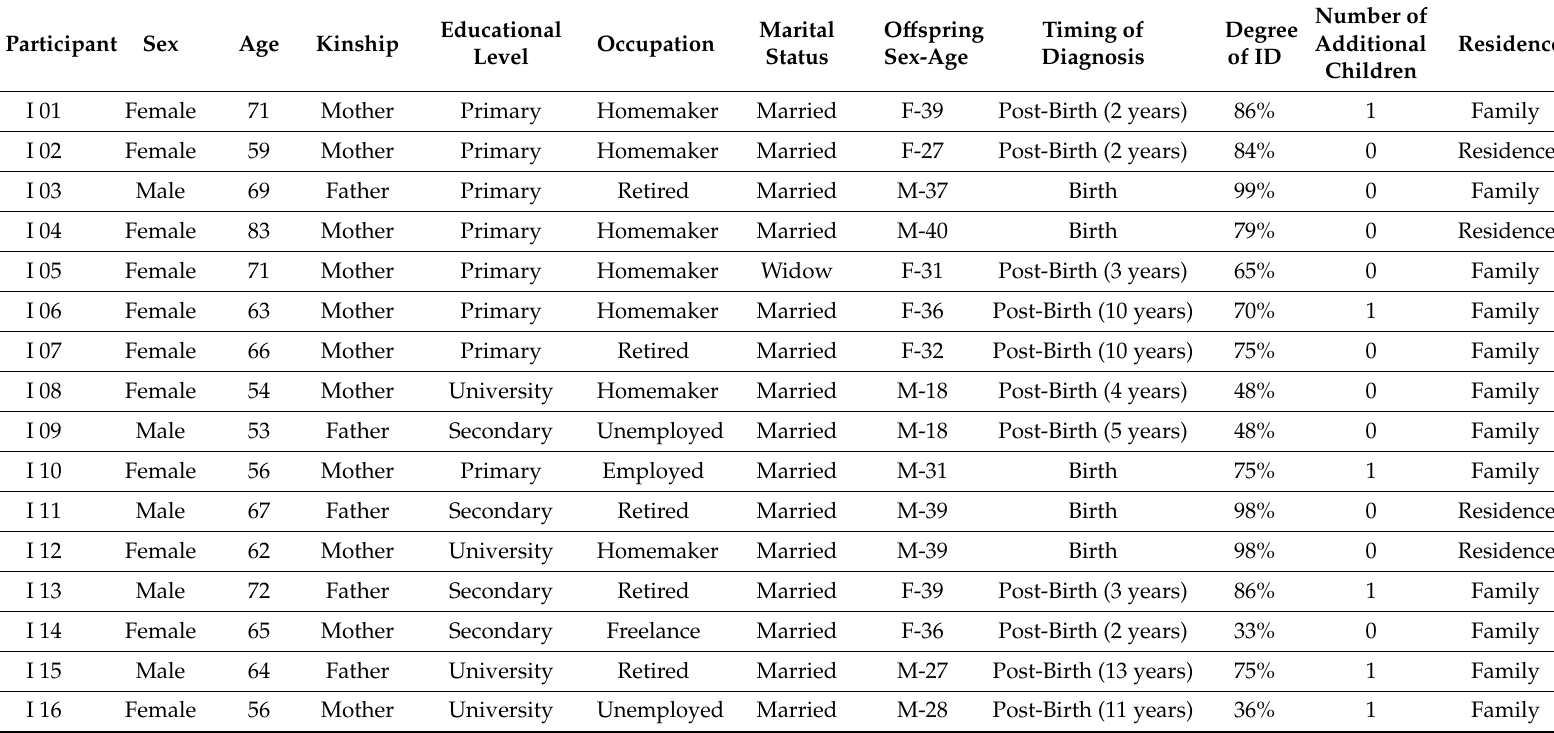
Table 1. Sociodemographic characteristics of the